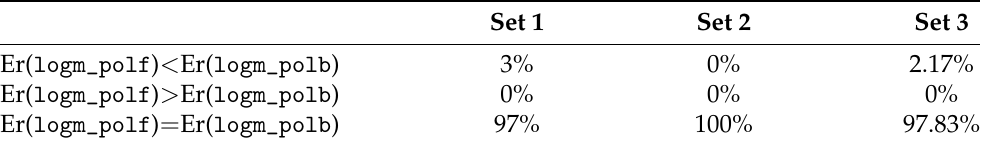
Table 4. Relative error comparison, for the three sets of matrices, between logm_polf and logm_polb . Set 1 Set 2 Set 3 Er( logm_polf ) < Er( logm_polb ) 3% 0% 2.17%